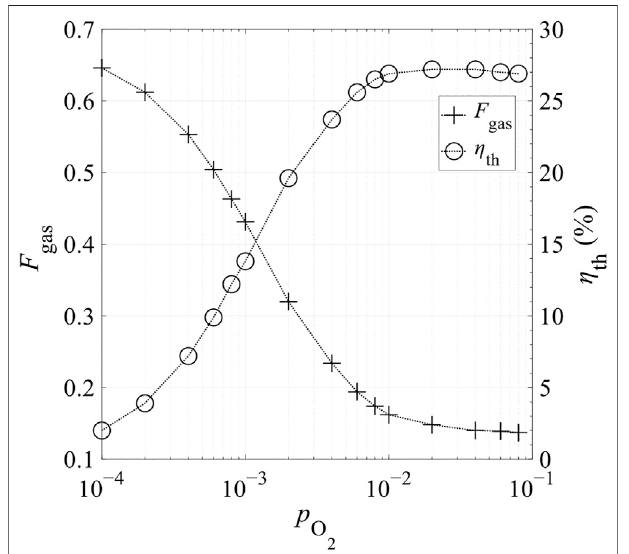
FIGURE 14 | Heat loss fraction corresponding to gas-phase heat recovery, F gas , and total thermal ef fi ciency η th as a function of relative oxygen partial pressure at the end of reduction, p O